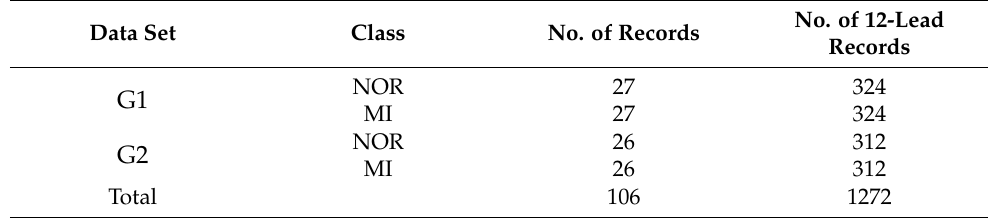
Table 1. The group separation with the number of records in each group from the PTB database. No. of 12-Lead Data Set Class No. of Records Records NOR 27 324 G1 MI 27 324 NOR 26 312 G2 MI 26 312 Total 106